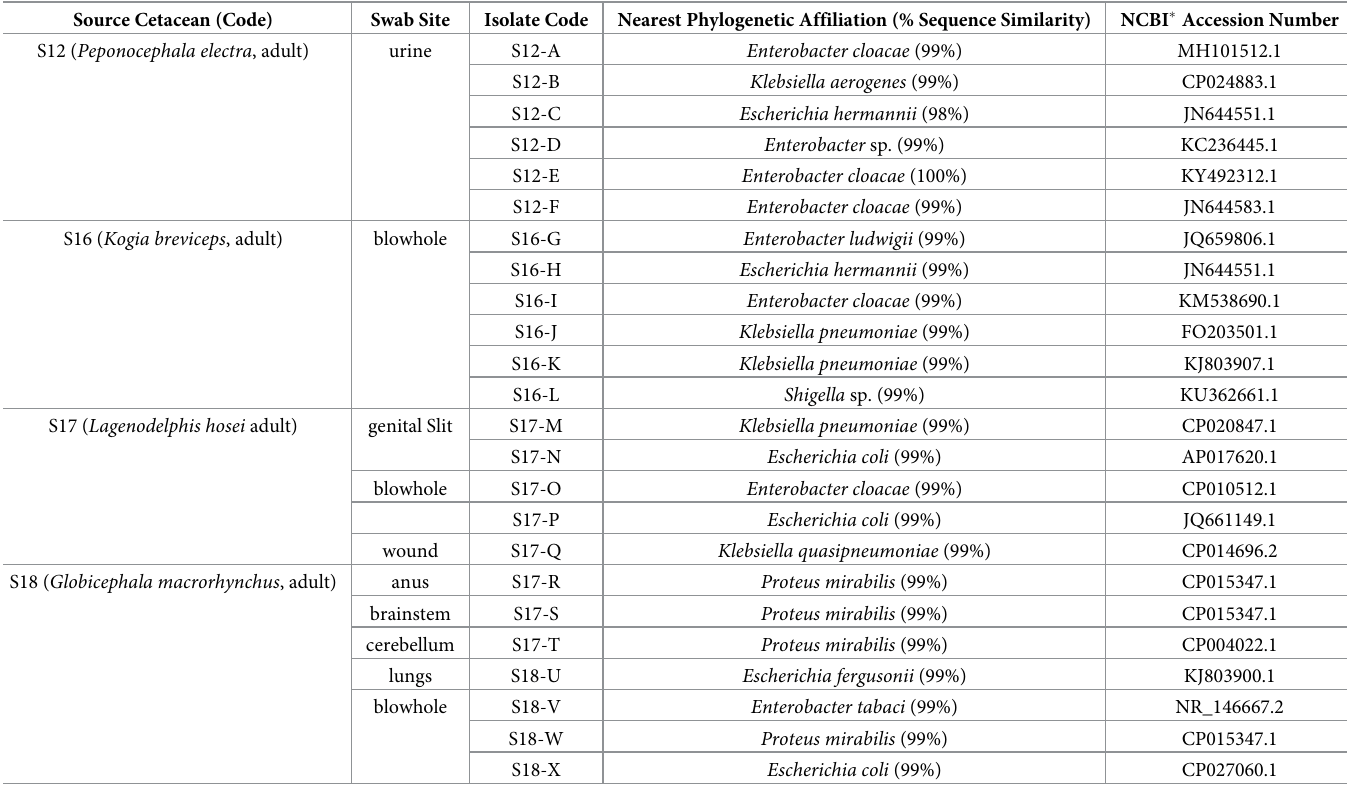
Table 4. Genotypic identification of bacteria isolated from stranded